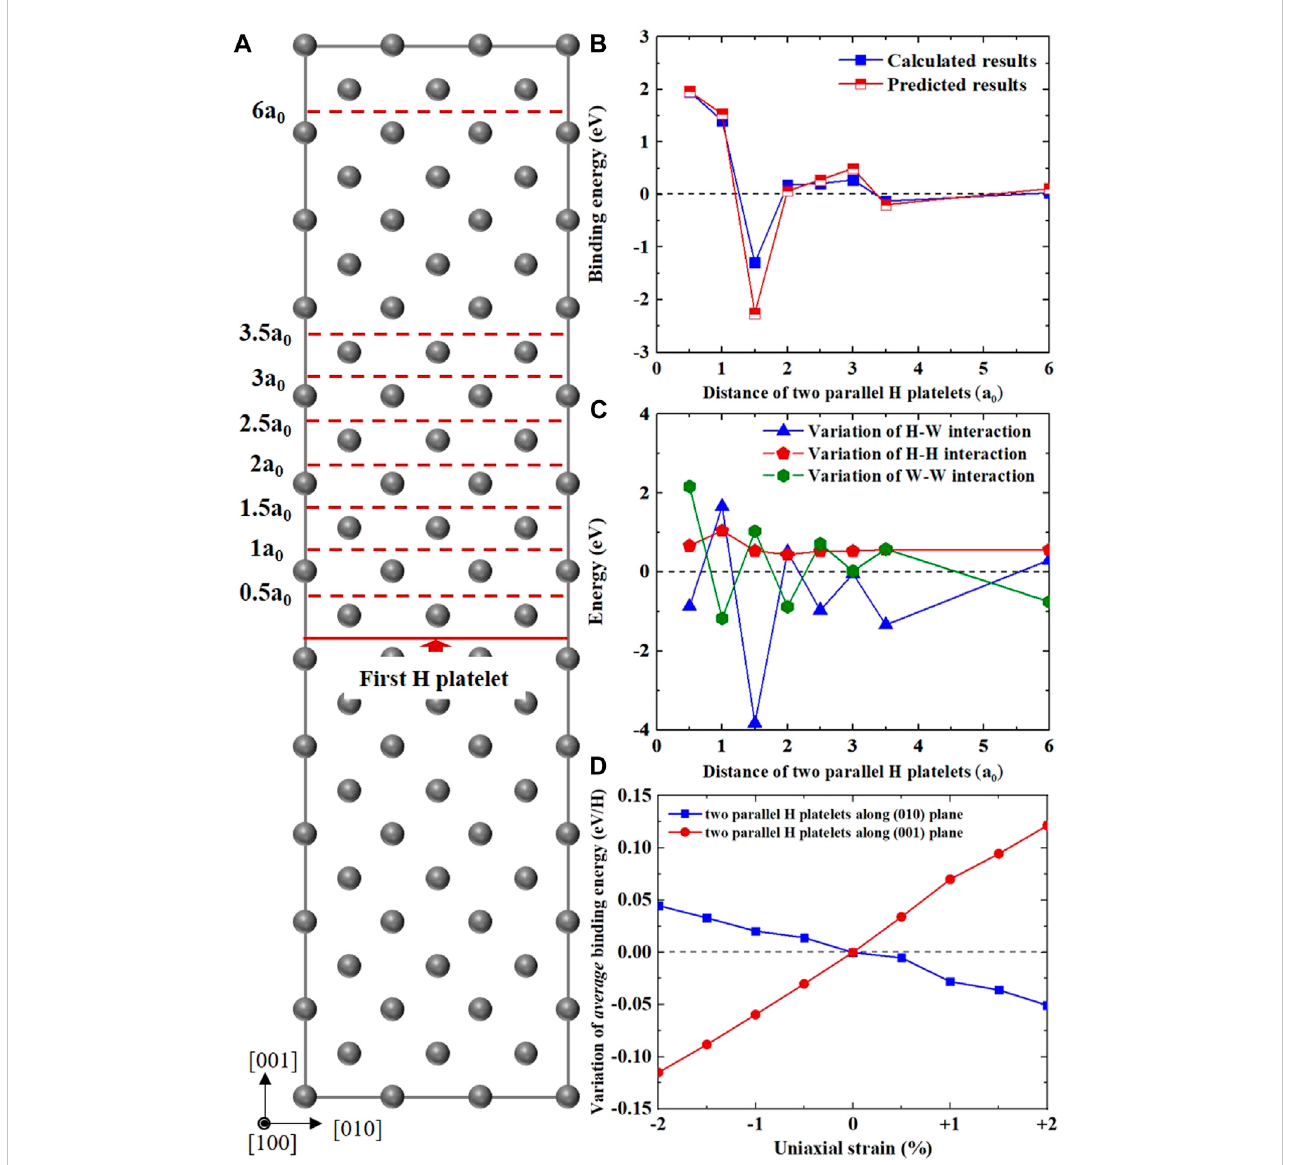
fi rst and second planar H clusters, respectively; (B) The calculated/ 0 to 6a 0 . The solid and dash red lines denotes the position of predicted binding energies of two parallel H platelets as a function of their vertical distance, and corresponding variation of H-W/H-H/W-W interactions are presentedin (C) ; (D) displaystheaveragebindingenergyvariationoftwoparallelHclustersinWasafunctionofuniaxialstrainfrom − 2%(compressive)to +2%